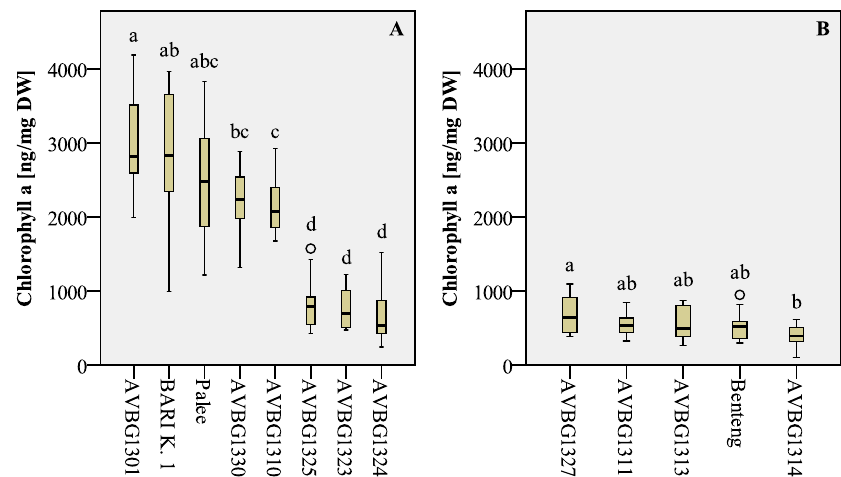
Fig. 6: Chlorophyll a contents of eight South Asian type (A) and five Southeast Asian (B) type bitter gourd entries cultivated in a greenhouse in Karlsruhe, Germany. Plots with same letters are not significantly different (P > 0.05). BARI K. 1 = ‘BARI Karella 1’. 10 fruits per entry. Open circles stand for outliers. Outliers were included in statistical